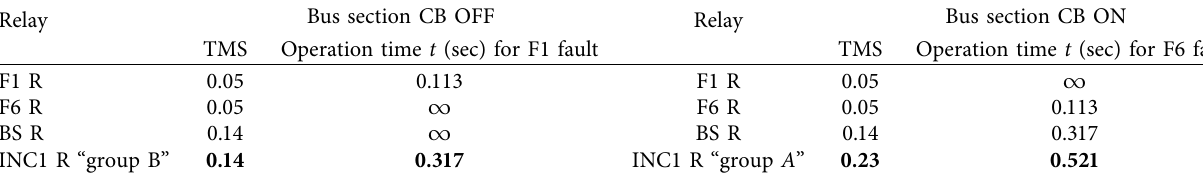
Table 3: Relays operation time for feeders 1 and 6 fault, for the proposed method.